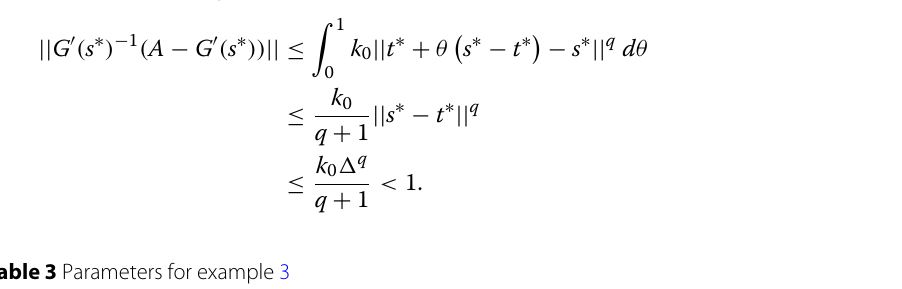
Table 3 Parameters for example 3 Algorithm(4)